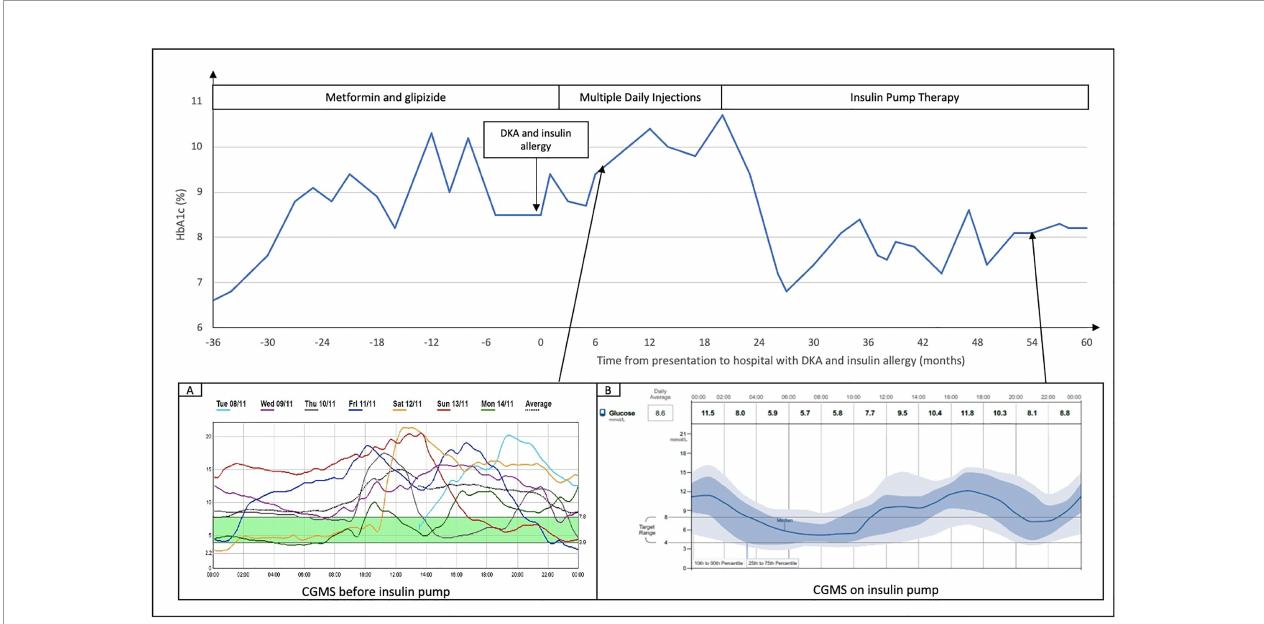
FIGURE 1 | Glycaemic control in this patient, re fl ected as HbA1c trend, and continuous glucose monitoring (CGMS) before (A) and after (B) insulin pump. Time on X axis is presented as months from presentation to hospital with severe DKA and insulin (detemir)